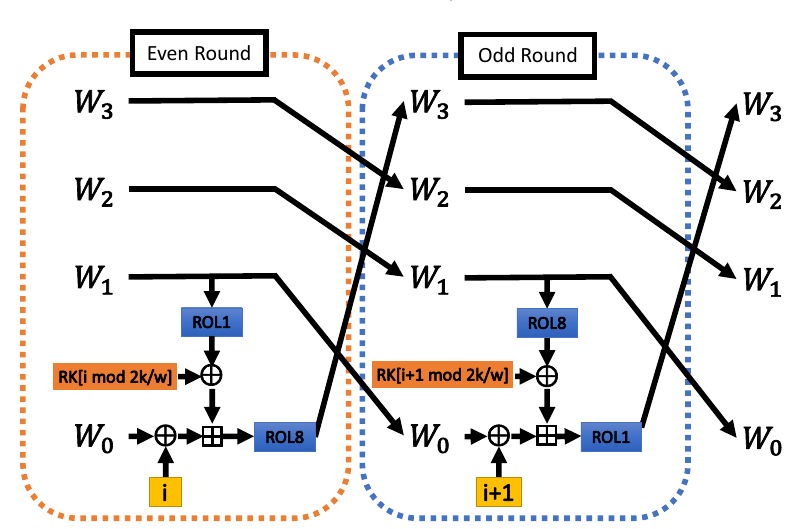
Figure 3. CHAM keyschedule.